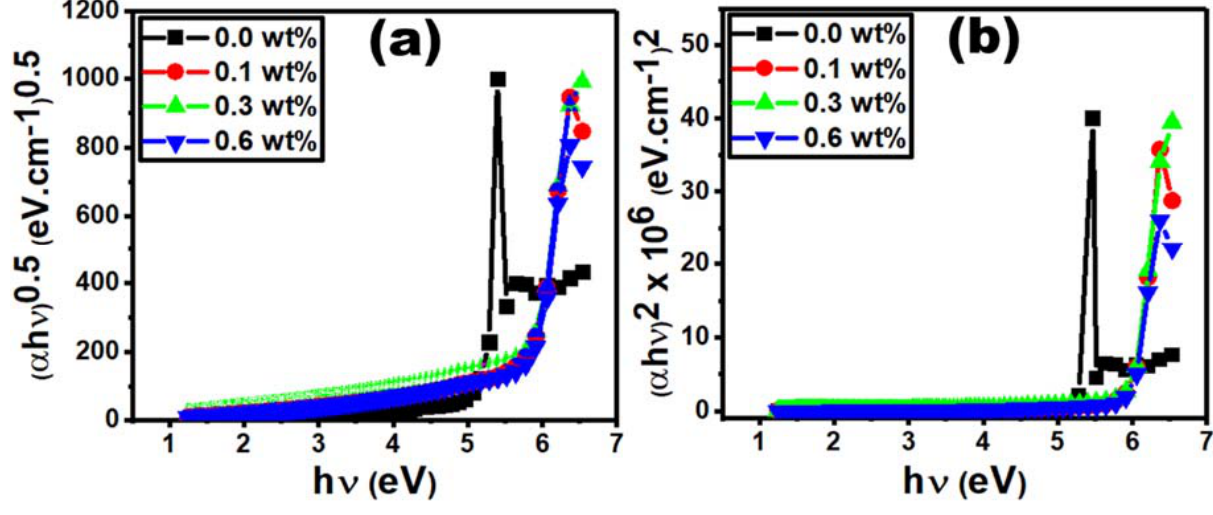
Figure 7. ( a ) ( α h υ ) 0.5 vs. h υ and ( b ) ( α h υ ) 2 vs. h υ for different Er 2 O 3 concentrations. Table 2. The optical parameters generated for the PVC/PVP/Er 2 O 3 polymer films.